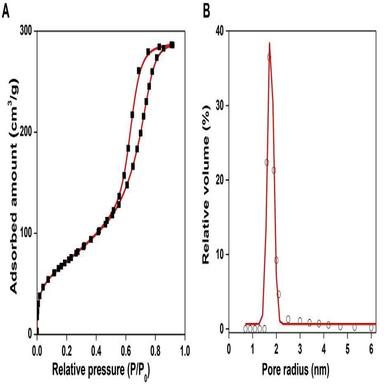
Nitrogen adsorption/desorption isotherms for mesoporous alumina. (B) Pore size distribution calculated for mesoporous alumina.